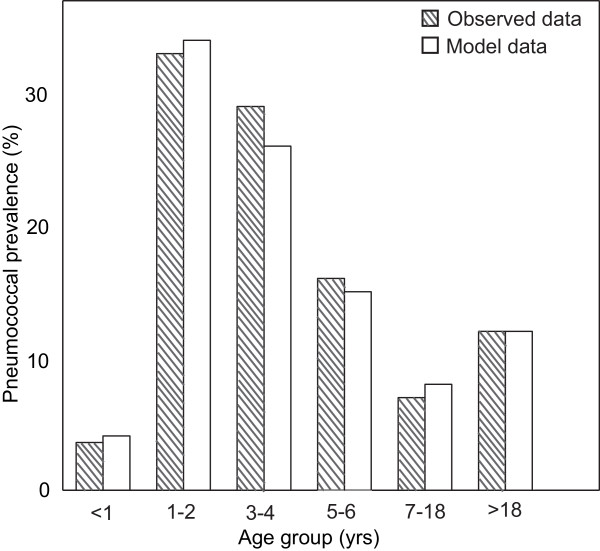
Age distribution for prevalence of pneumococcal carriage. The distribution for prevalence of pneumococcal carriage in different age groups resulted from the model simulations compared with observed data. From Högberg et al. (2007) [12] observed data are derived, whereas model data are the mean values of 100 baseline simulations (Age group < 1 yr: mean 4.1%; 95% CI 3.9–4.2%; Age group 1–2 yrs: mean 34.0%, 95% CI 33.2–35.2%; Age group 3–4 yrs: mean 26.5%, 95% CI 25.7–27.2%; Age group 5–6 yrs: 15.4%, 95% CI 14.9–15.9%; Age group 7–18 yrs: mean 8.0%, 95% CI 7.8–8.3%; Age group >18 yrs: 11.9%, 95% CI 9.8–13.9%).